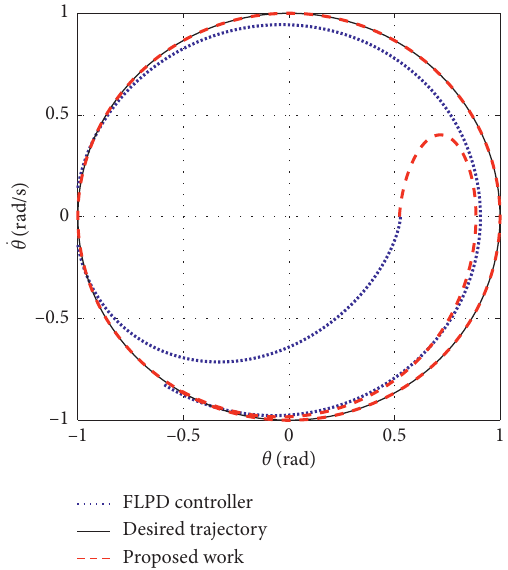
Figure 11: Phase plane diagram for the flexible